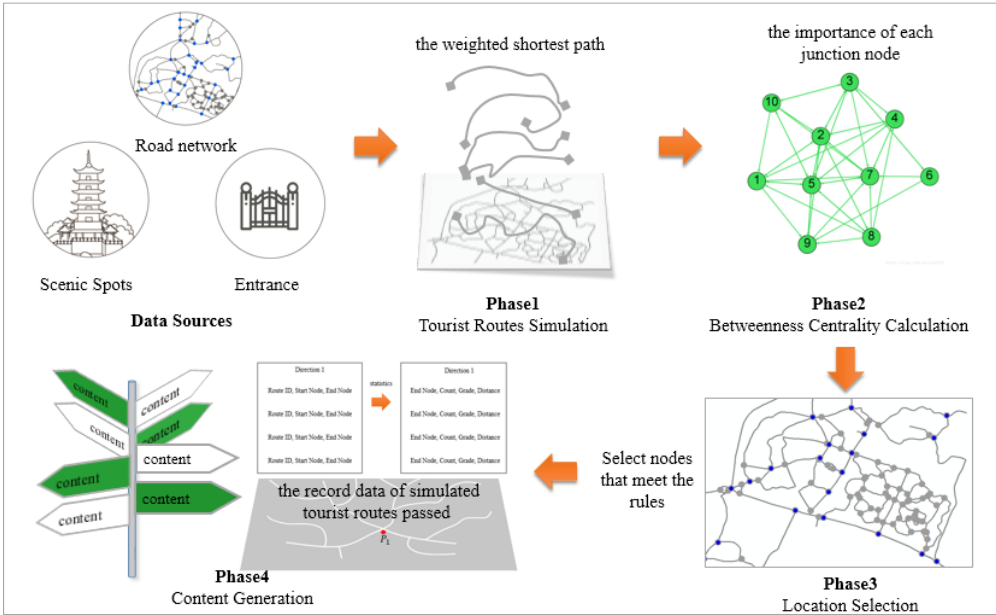
Figure 2. The four main phases of the basic idea in this paper.